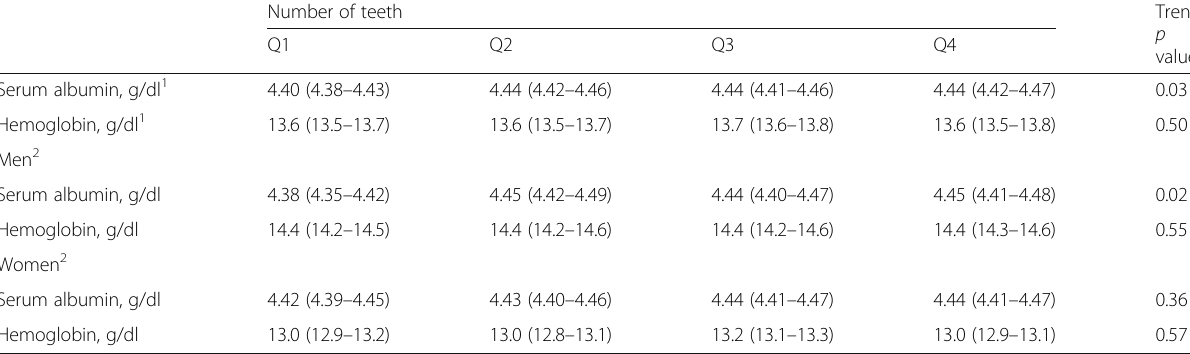
Table 4 Adjusted means of blood biomarker levels by the number of teeth (brackets contain 95% confidence intervals) Number of